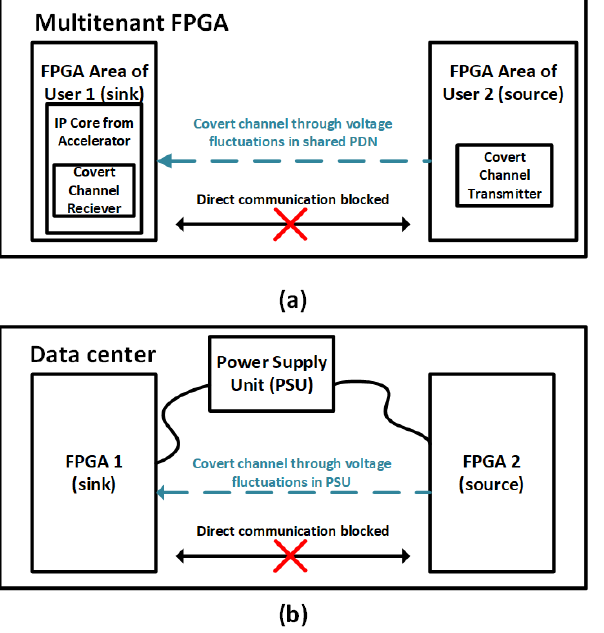
Figure 5. Voltage-based covert channels as a threat between ( a ) a multi-tenant FPGA [54], ( b ) two FPGAs in a data center sharing the same power supply unit (PSU)